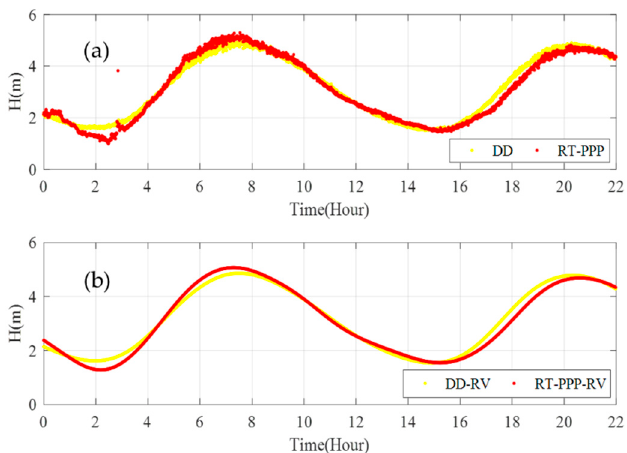
Figure 13. Comparison of the RT-PPP tide measurement results with the DD method based on BJFS. ( a ) Shows the instantaneous sea level, ( b ) shows the filtered tide values. Table 6. Comparison of the RT-PPP tide measurement results with the DD method based on BJFS. Before Filtering After Filtering Compared Bias(m) Bias(m) Methods RMS(m) RMS(m) Max Average Max Average RT-PPP - DD 2.028 0.166 0.213 0.415 0.155 0.194